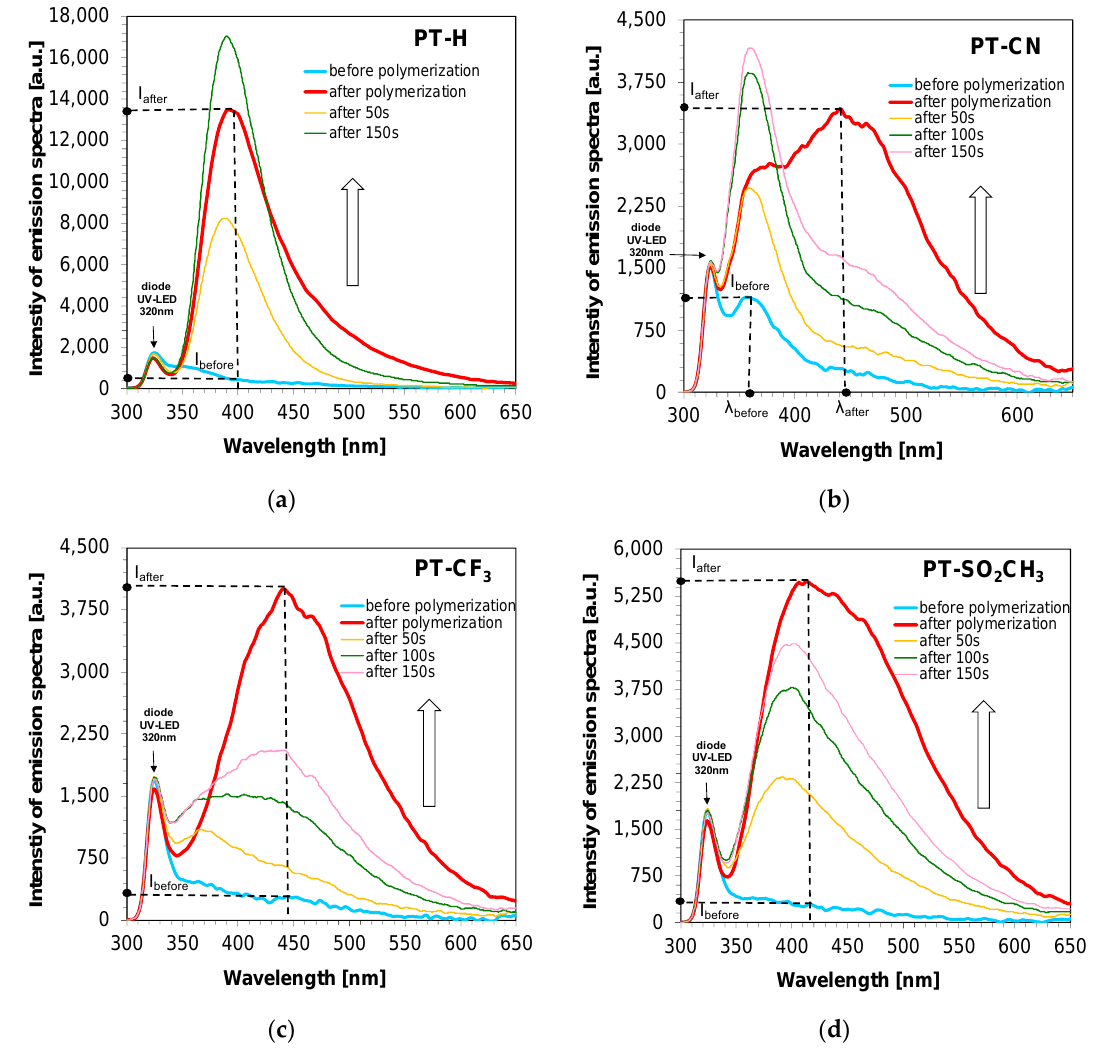
Figure 10. Changes of fluorescence spectra during cationic photopolymerization of TEGDVE monomer under irradiation 320 nm for ( a ) PT-H sensor; ( b ) PT-CN sensor; ( c ) PT-CF 3 sensor; ( c ) PT-SO 2 CH 3 sensor. Table 5. Spectroscopic data of the 2,6-diphenylpyridine derivatives during the cationic photopolymerization